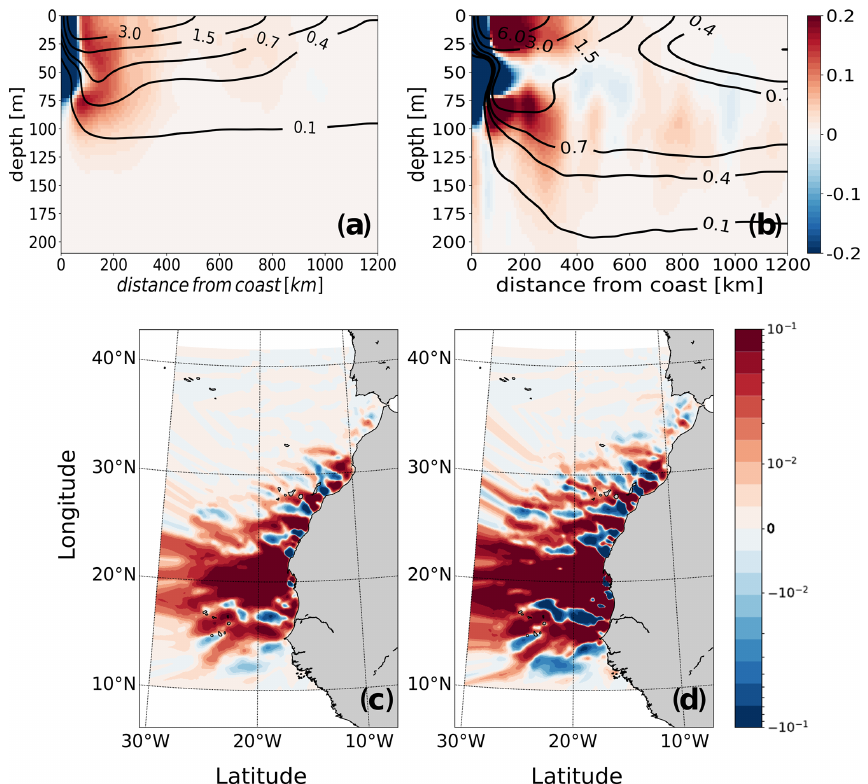
Figure 7. Analysis of the structure of the offshore transport of nitrogen: (a, b) offshore sections of the meridionally integrated net downward and offshore transports of (a) organic and (b) inorganic nitrogen in the upper 200m as a function of the distance to the coast. Positive (red) and negative (blue) shadings represent net downward and net upward transports (in GmolNkm − 1 yr − 1 ), respectively, and contours correspond to the offshore transport (in GmolNm − 1 yr − 1 ). The fluxes were meridionally integrated throughout the domain. (c, d) Maps of the vertically integrated offshore transport of (c) organic and (d) inorganic nitrogen, where positive (red) and negative (blue) shadings represent net offshore and onshore transports, respectively (in GmolNkm − 1 yr − 1